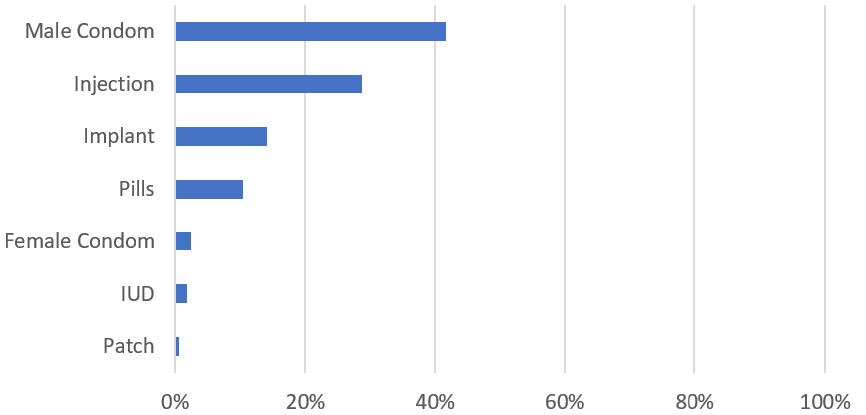
Figure 1. Used methods of contraception.